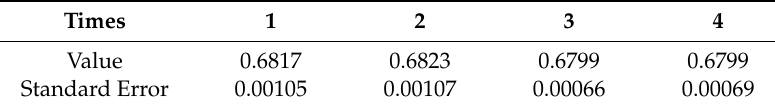
Table 2. Linear fitting parameter.